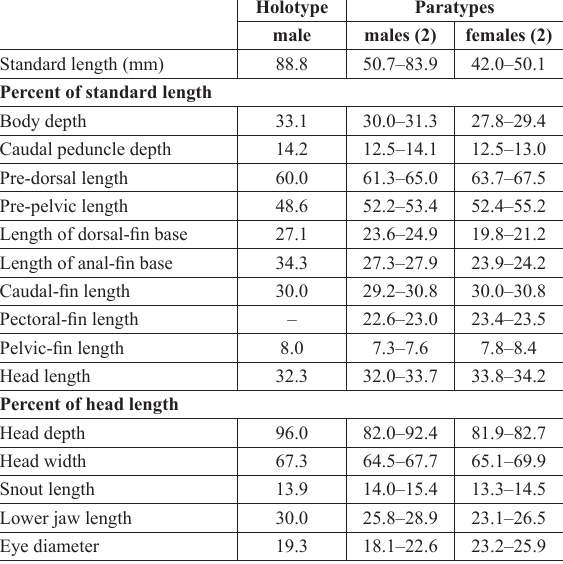
Table 2. Morphometric data of Cynolebias gorutuba